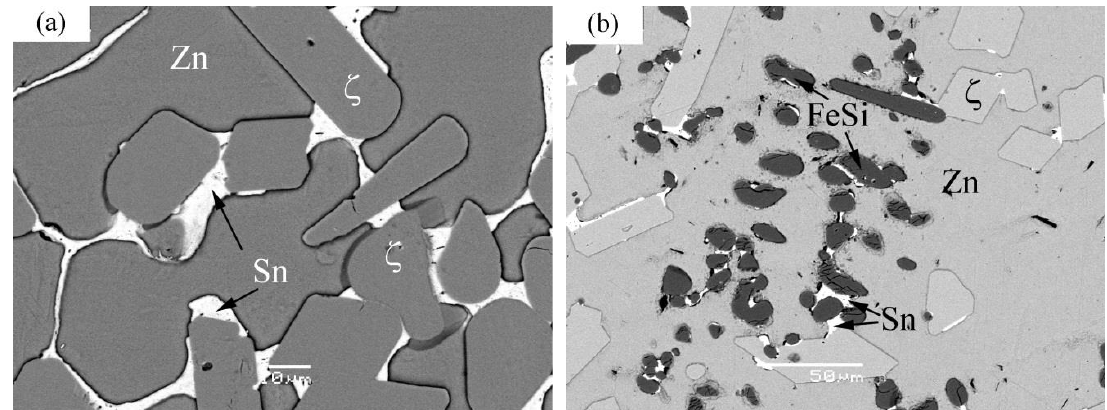
Figure 11. The SEM images of Alloys B1 and B5. ( a ) The microstructure of Alloy B1. ( b ) The microstructure of Alloy B5.